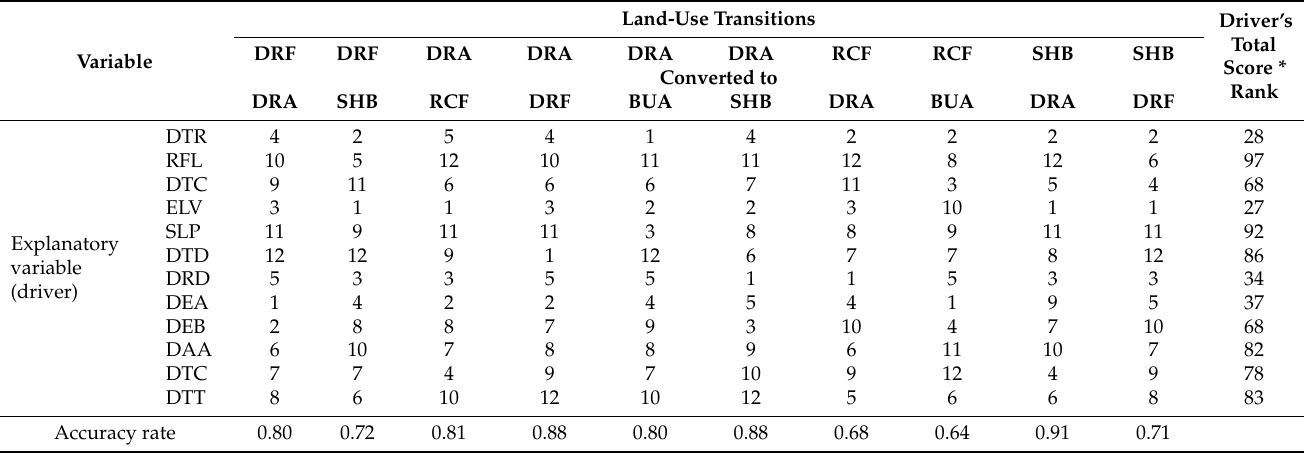
Table 4. Relative importance of each driver for each land-use transition and model performance in explaining